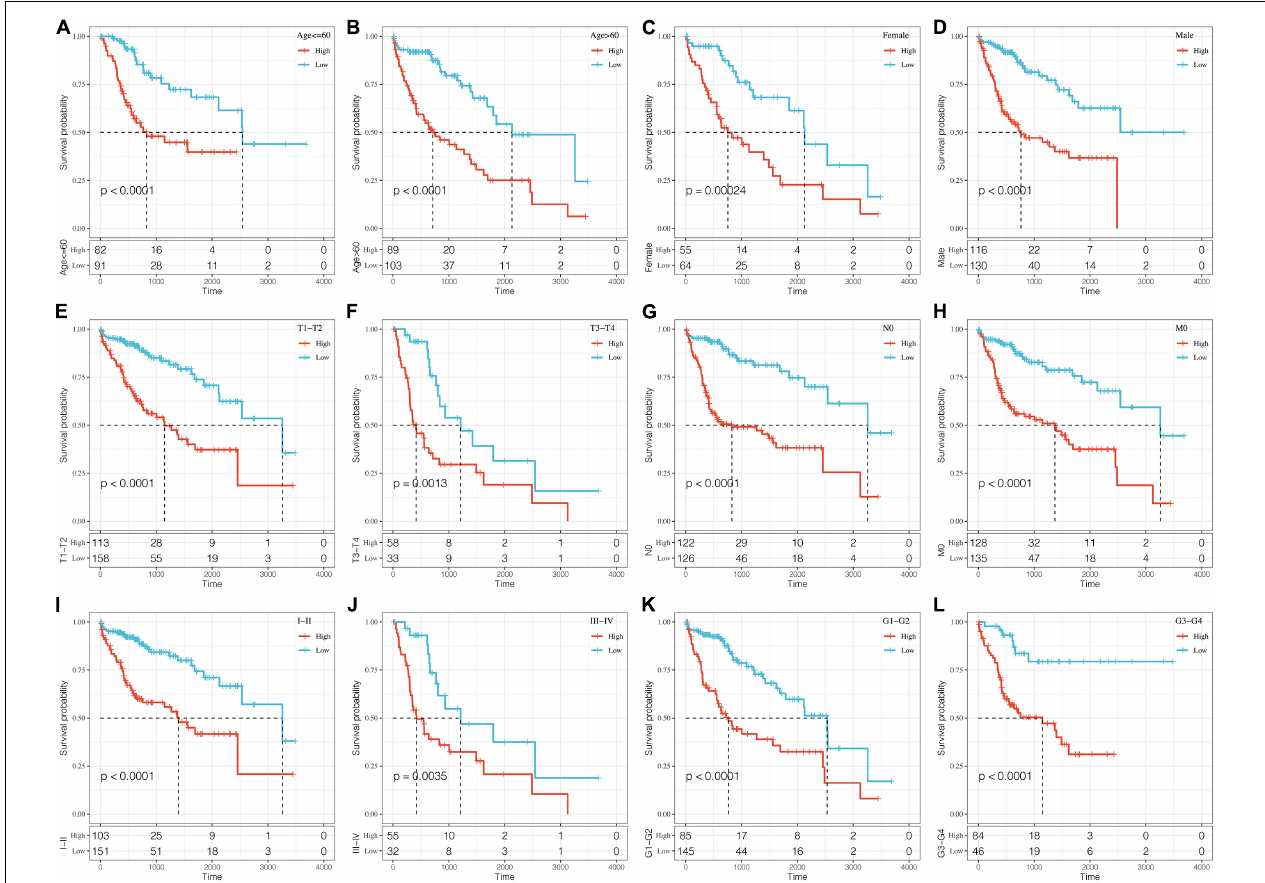
FIGURE 6 | Prognostic analysis of clinical subgroups based on RiskScore. The horizontal axis represents survival time, and the vertical axis represents survival probability. Blue represents low expression group; red represents high expression group. (A–L) Based on Riskscore, survival curves were analyzed for Age ≤ 60, Age > 60, Female, Male, T1 + T2, T3 + T4, N0, M0, Stage I + II, Stage III + IV, Grade 1 + 2, and Grade 3 + 4 groups,